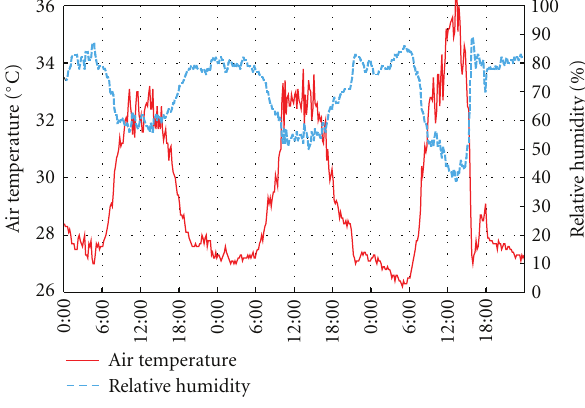
Figure 4: Weather conditions on August 3 to 5, 2005.